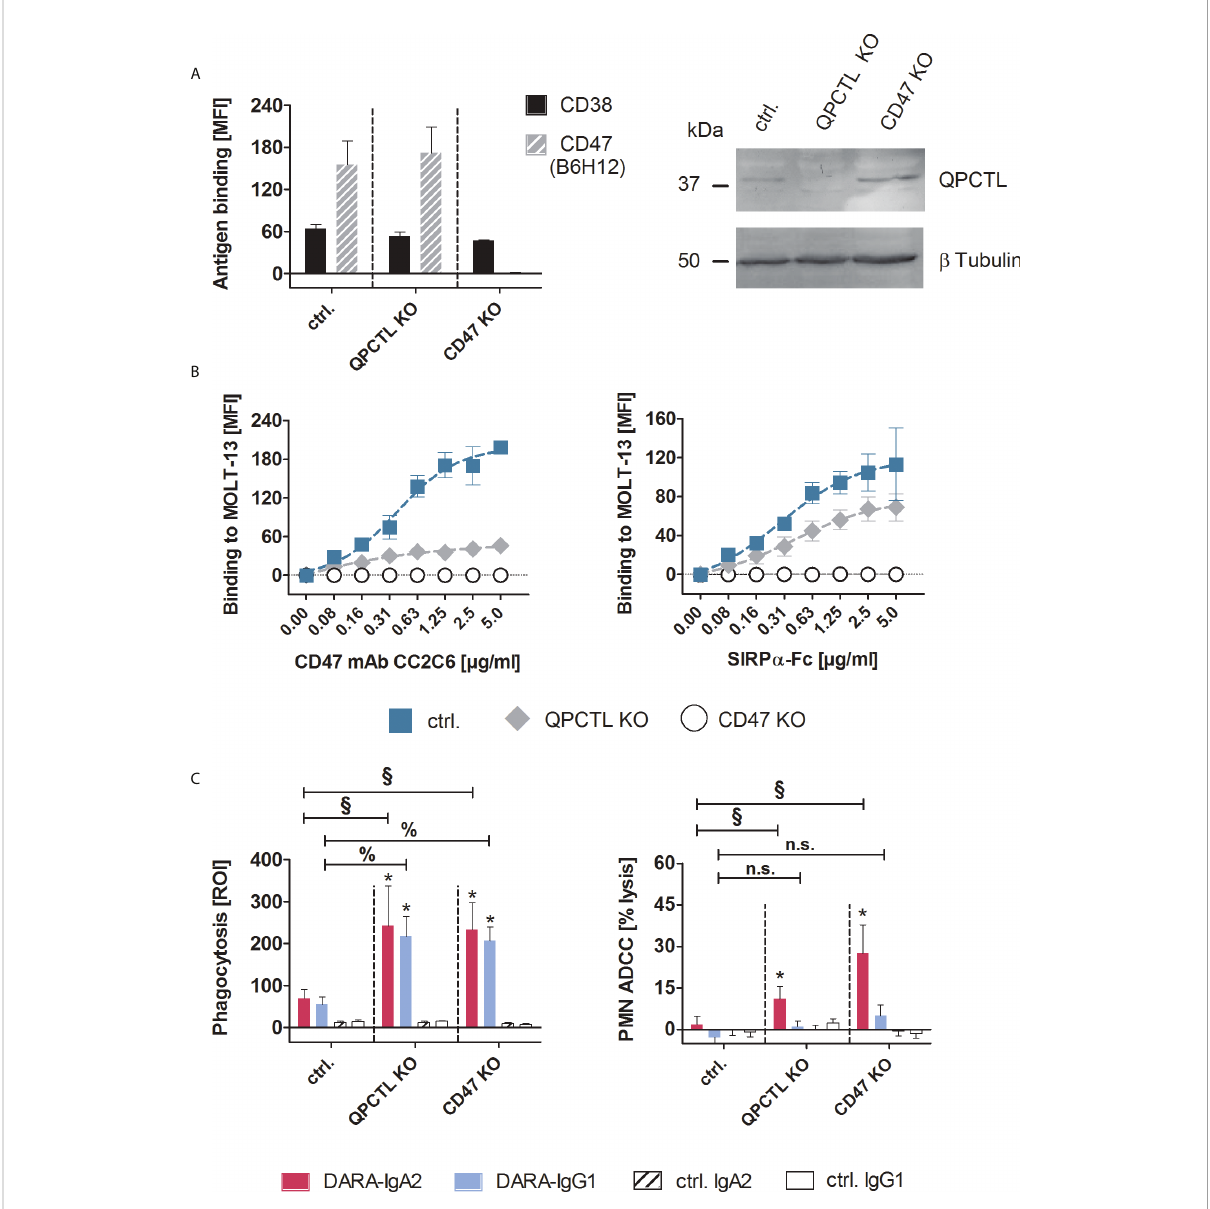
FIGURE 2 Genetic knock-out of CD47 or QPCTL improved myeloid cell-mediated T-ALL cell killing by IgG1 and IgA2 variants of daratumumab. (A) MOLT- 13 QPCTL and CD47 knock-out (KO) cells were tested for the expression of CD38 and CD47 using antibody clones HB-7 and B6H12, respectively. The CD47 antibody B6H12 is pyro-glutamate independent and detects overall expression of the antigen. Control cells (ctrl.) were treated with Cas9 without QPCTL gRNA. Antibodies were used at saturating concentrations (5 µg/ml) and detected with FITC-conjugated goat anti-mouse Fc g -speci fi c F(ab) 2 fragments (left panel, n=3). Knock-out of QPCTL was con fi rmed by immunoblotting (right panel), b -tubulin was used for loading control. (B) Binding of the pyro-glutamate dependent CD47 antibody CC2C6 (left panel) and soluble SIRP a -Fc fusion protein (right panel) on MOLT-13 control and knock-out cells was measured by indirect immuno fl uorescence and staining with FITC-conjugated goat anti-mouse or goat anti-human Fc g speci fi c F(ab) 2 fragments. MFI values ± SEM of 3 independent experiments are shown. Background fl uorescence of unlabeled cells was subtracted from each MFI value. (C) QPCTL KO and CD47 KO as well as control MOLT-13 cells were used as targets in macrophage-mediated ADCP (left panel) and in PMN-mediated ADCC (right panel) with DARA-IgA2 and DARA-IgG1 at 10 µg/ml. For ADCP, an E:T cell ratio of 1:1 was applied. Mean values ± SEM of the red object counts per image (ROI) after 4 h are shown (n=3 with different donors). PMN-mediated ADCC was determined by 51 Cr release assays with GM-CSF (50 U/ml) stimulated PMN at an E:T ratio of 80:1. Percentage of mean lysis ± SEM of 4 independent experiments with effector cells from different donors are shown. * indicates signi fi cant differences between DARA and isotype control (p < 0.05 by two-way ANOVA). Signi fi cant differences between the KO variants and the control cells are indicated by § for DARA-IgA2 and by % for DARA-IgG1 (p < 0.05 by two-way ANOVA). n.s., not signi fi cant. KO, knock-out; QPCTL, glutaminyl-peptide cyclotransferase like; MFI, mean fl uorescence intensity; ROI, red object count per